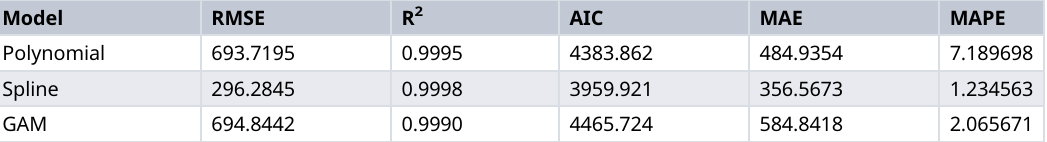
Table 1. RMSE, R 2 and AIC for the Polynomial, Spline and GAM models.